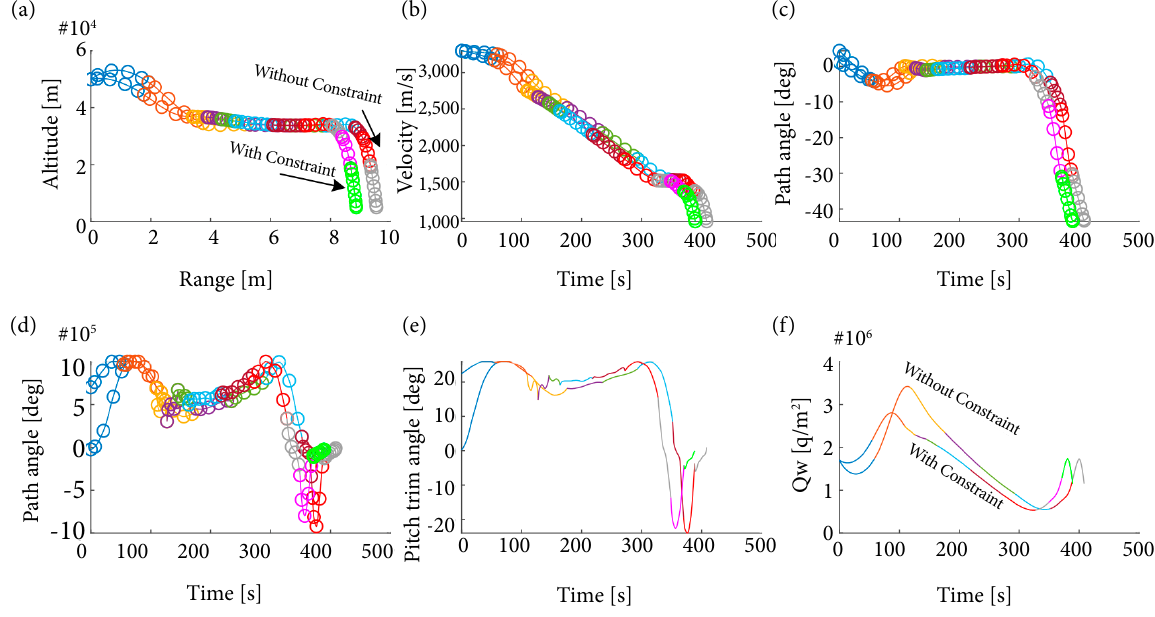
Figure 13. The trajectory constrained of heating rate in situation of b